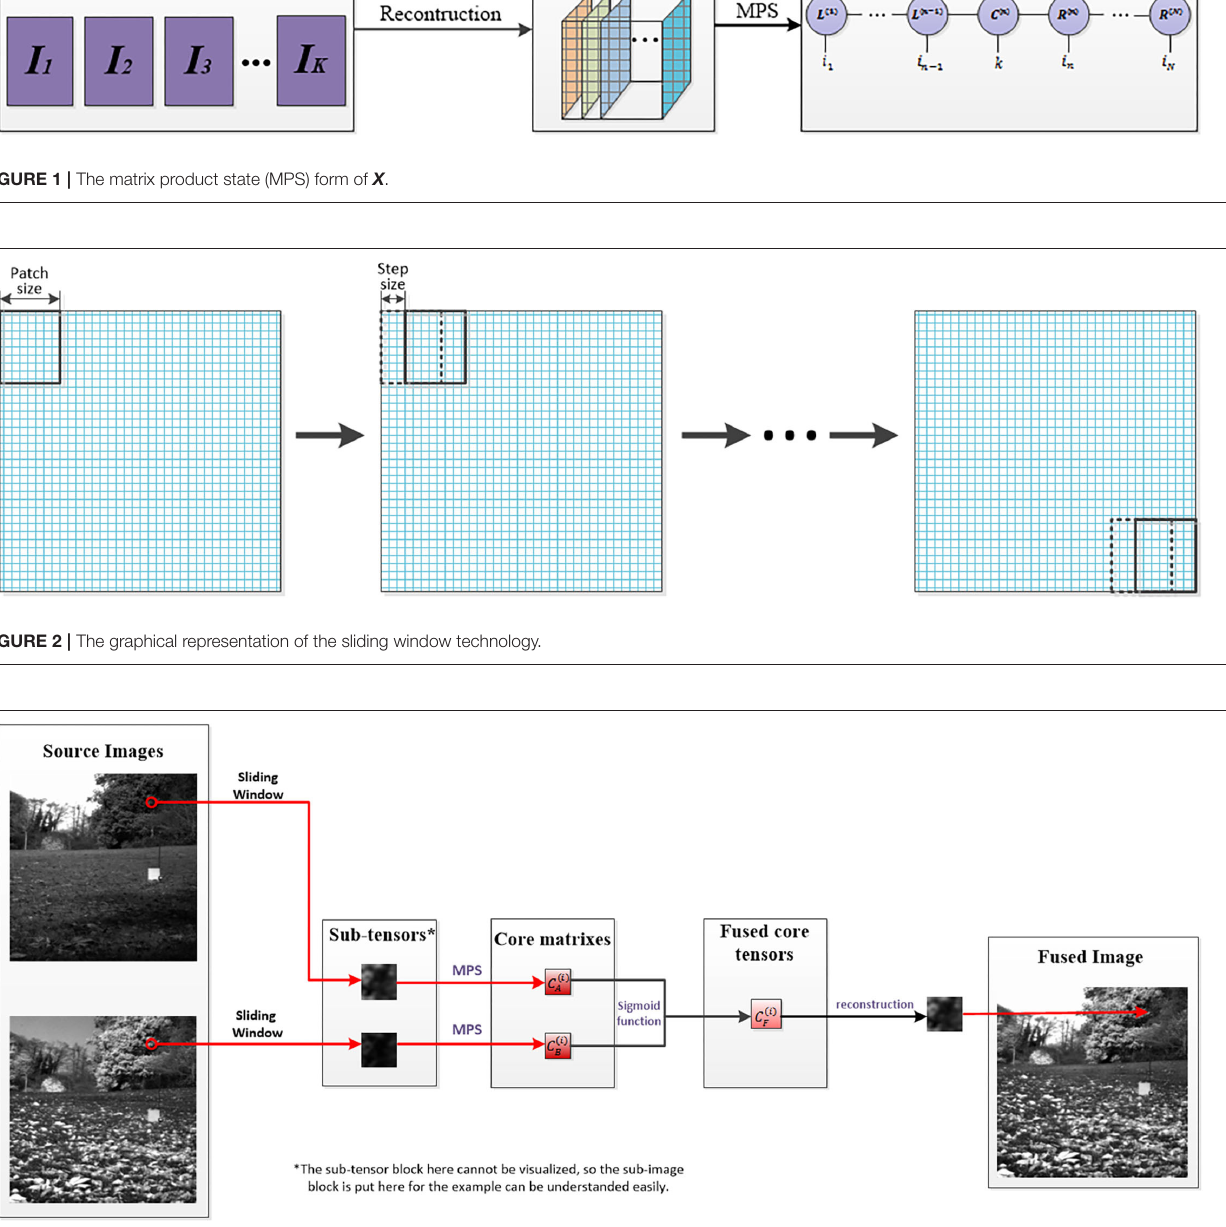
FIGURE 3 | An example for visualizing the process of decomposition and